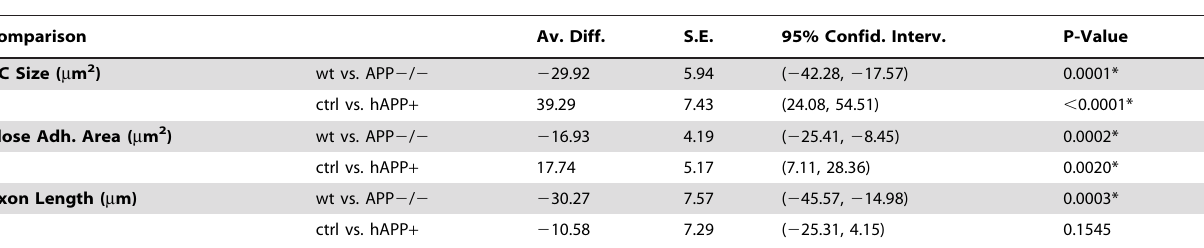
Table 2. GCs on Laminin, Statistical